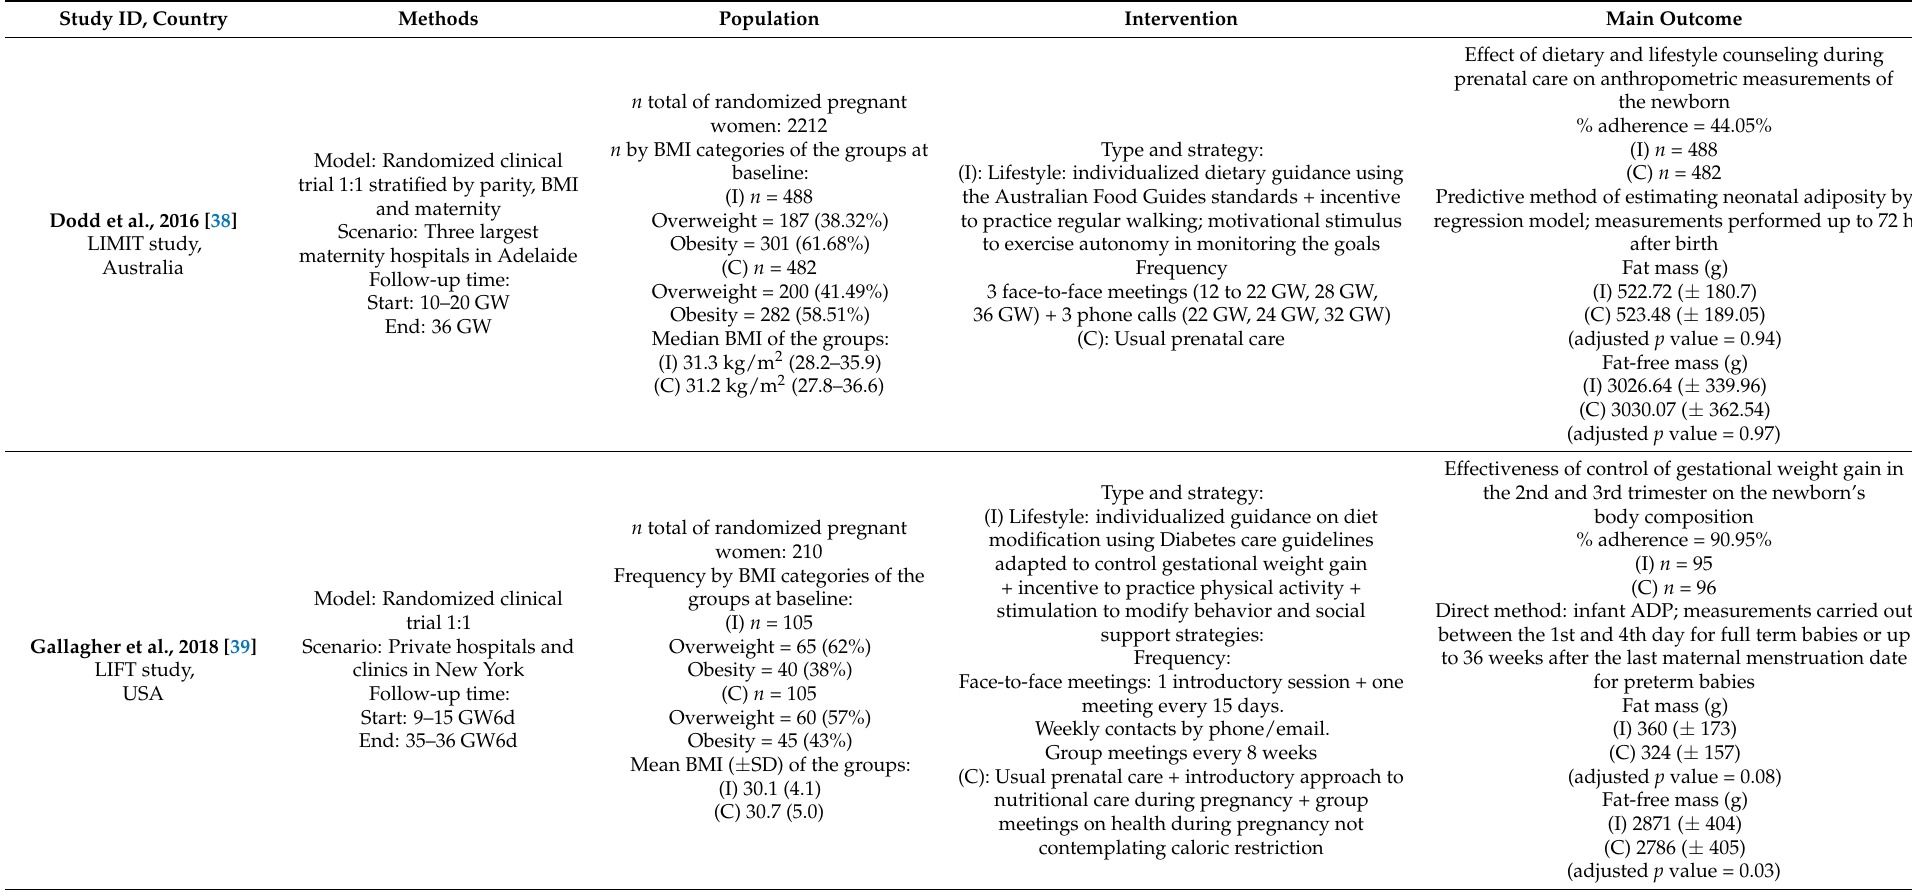
Table 1. Characteristics of the included